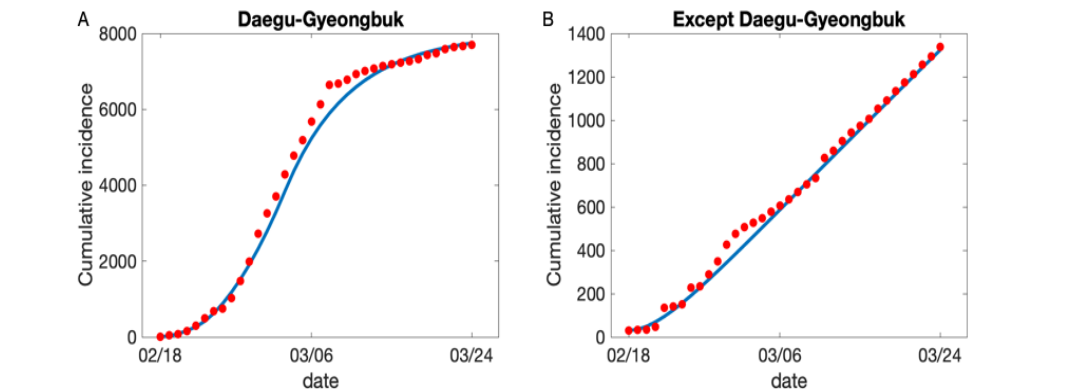
Figure 5. ( A ) Model calibration to Daegu-Gyeongbuk incidence data (blue solid line: model prediction, red dots: data. ( B ) Model calibration to South Korea incidence data except Daegu-Gyeongbuk area.